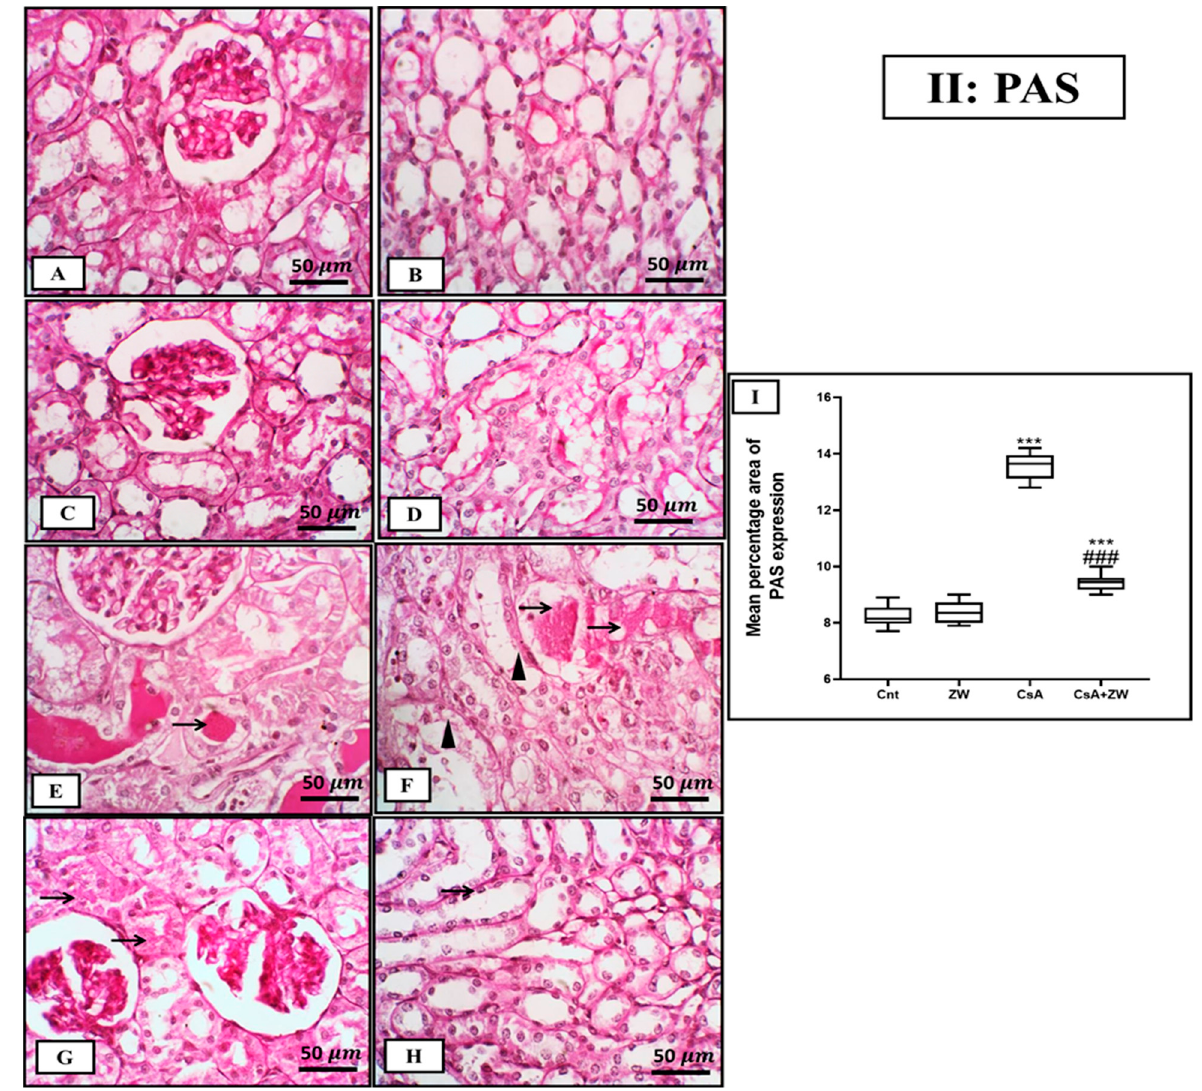
Figure 2. Photomicrograph of PAS expression in kidneys from control and experimental rats. ( A – D ) The control and ZW groups show PAS highlights of the glomerular basement membrane and tubular epithelium of the cortical and medullary region. ( E , F ) The CsA group shows PAS-positive staining in the dilated cortical and medullary tubules (arrowheads) with intraluminal proteinaceous globules (thin arrows). ( G , H ) The CsA + ZW group shows focal intracytoplasmic-positive PAS in the tubular epithelium of the cortex and the positive staining of the tubular basement membrane of medullary tubules (thin arrows). ( I ) Histogram of the percentage area of PAS expression. *** p < 0.001 vs. control ; ### p < 0.001 vs. CsA. Image magni fi cation = 400×, bar = 50 µm.